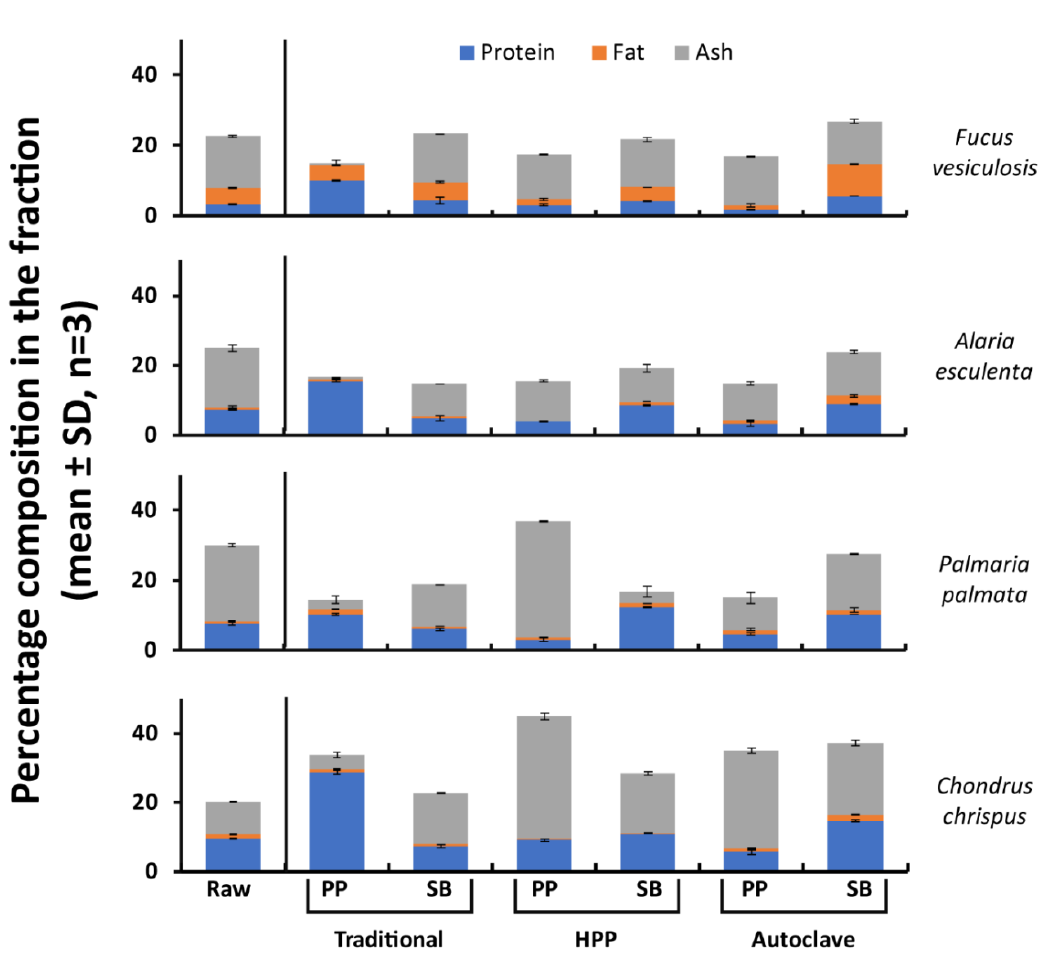
Figure 2. Proximate analysis of each seaweed species by pre-treatment method. Raw = raw biomass, PP = protein pellet, SB = spent biomass.